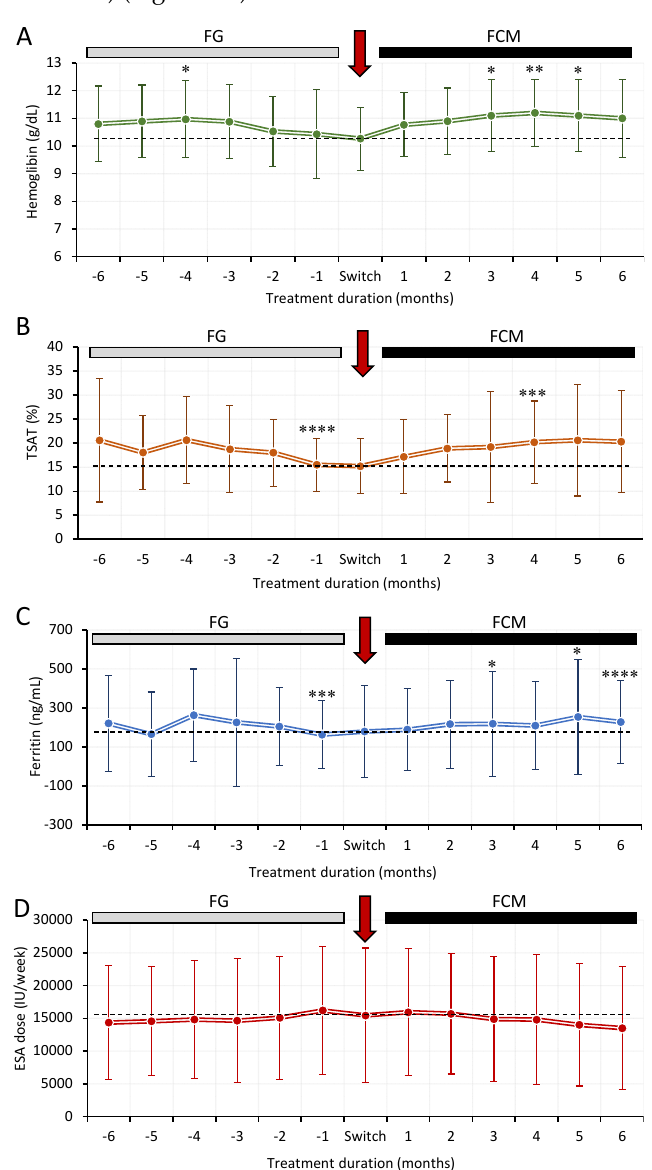
Figure 3. Secondary efficacy measures in hemodialysis patients who switched from FG to FCM. ( A ), change in haemoglobin levels during FG and FCM treatments over the 12 months. ( B ), change in TSAT levels during FG and FCM treatments over the 12 months. ( C ), change in ferritin levels during FG and FCM treatments over the 12 months. ( D ), change in ESA dose during FG and FCM treatments over the 12 months. Dotted line represents levels of variables at the switch visit. Data are presented as mean ± SD. p -values denote statistical significance for FG treatment (vs. − 6 months) or FCM treatment (vs. switch visit) where * = <0.05, ** = <0.01, *** = <0.001 and **** = <0.0001. ESA = erythropoietin stimulating agent, TSAT = transferrin saturation.